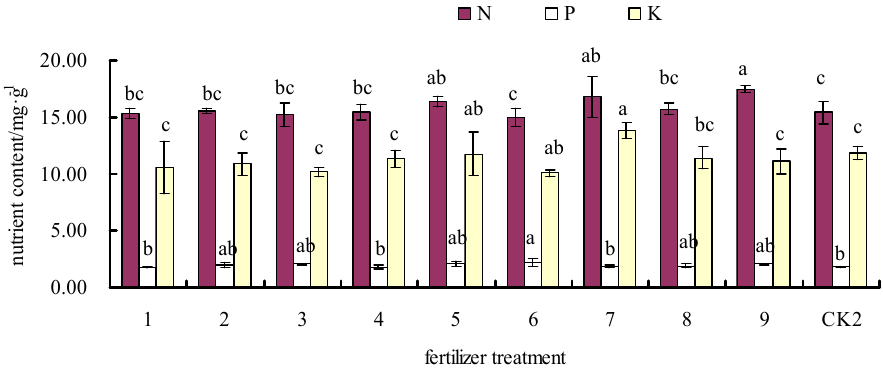
Figure 4. Effects of combined N, P, and K fertilizer application on G. biloba leaf N, P, and K contents in EXP.2.